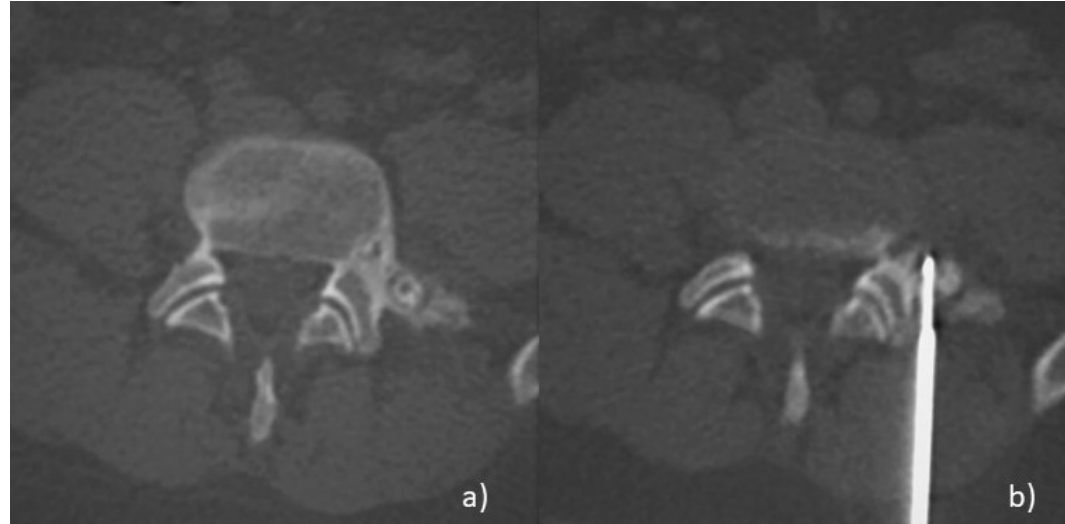
Figure 2. Radiofrequency-ablation (RFA) of a vertebral Osteoblastoma (OB). ( a ) Axial-CT image of OB located in the transverse process of a lumbar vertebra, near the spinal root. ( b ) Axial-CT image during the treatment: under CT-guidance, an RF probe with an exposed tip is perfectly located into the nidus; it is possible to achieve the complete and radical ablation of the lesion. A safety distance of about 1cm is ensured, between the exposed tip and the adjacent critical anatomical structures.